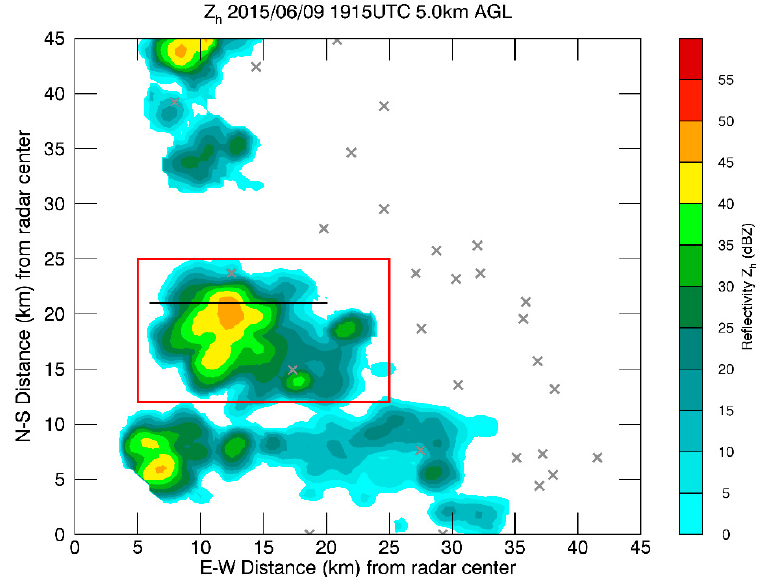
Figure 2. Z h at 5 km AGL on 06/09/2015 at 1915 UTC. The spatial definition of a cell associated with a wind event is highlighted as a red box, and the gray ‘X’s show Cape WINDS tower locations. The solid black line indicates the plane of the vertical-cross section shown in Figure 3.